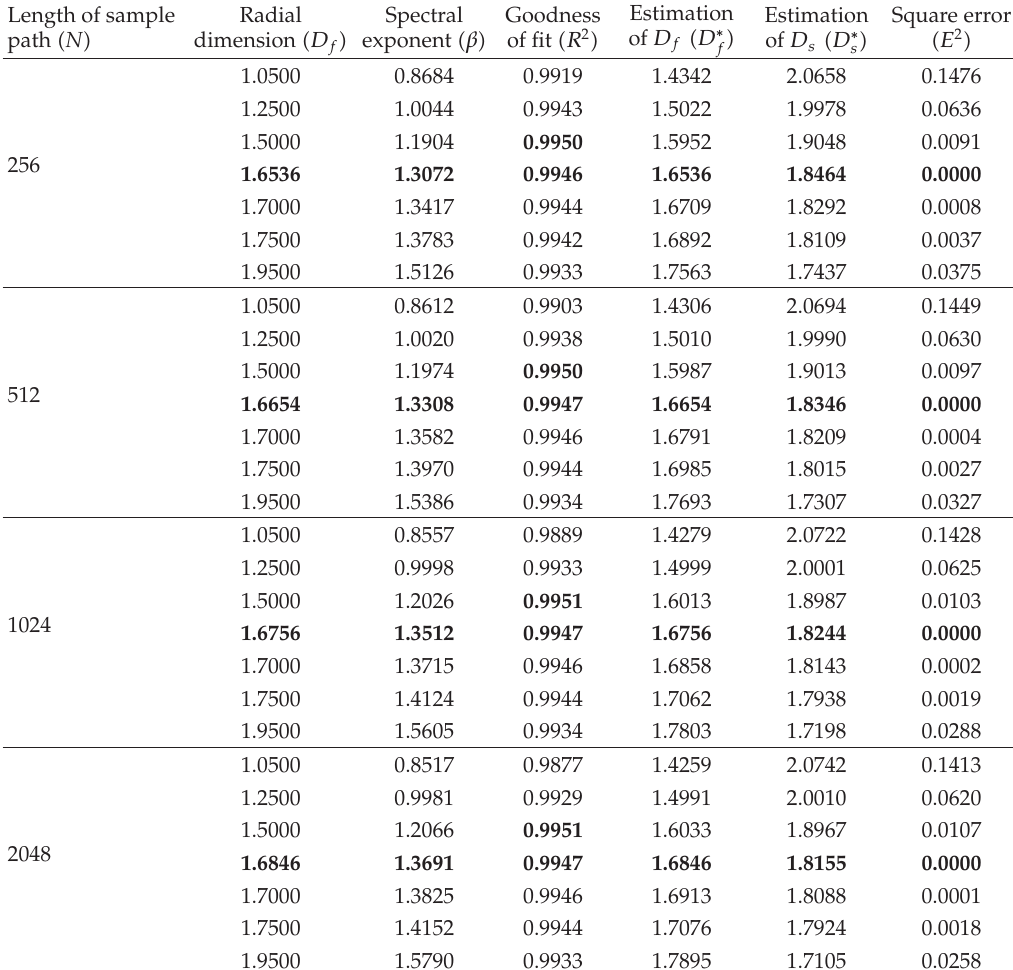
Table 2: Comparison between the fractal dimension values of an imaginary city form and its estimated results from the spectral